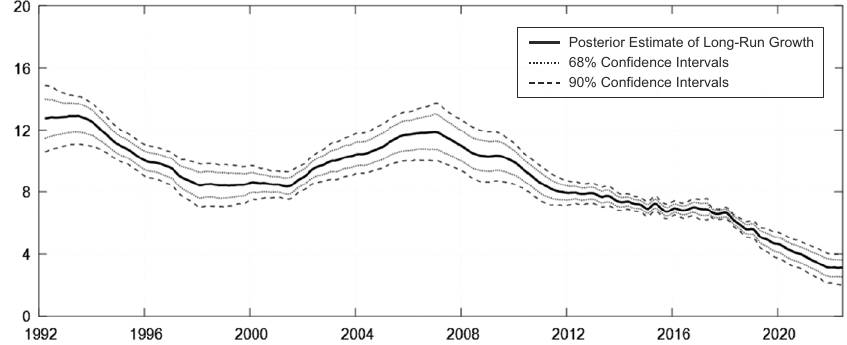
Figure 1. Long-term economic growth trend measured by a TVP–MF–DFM